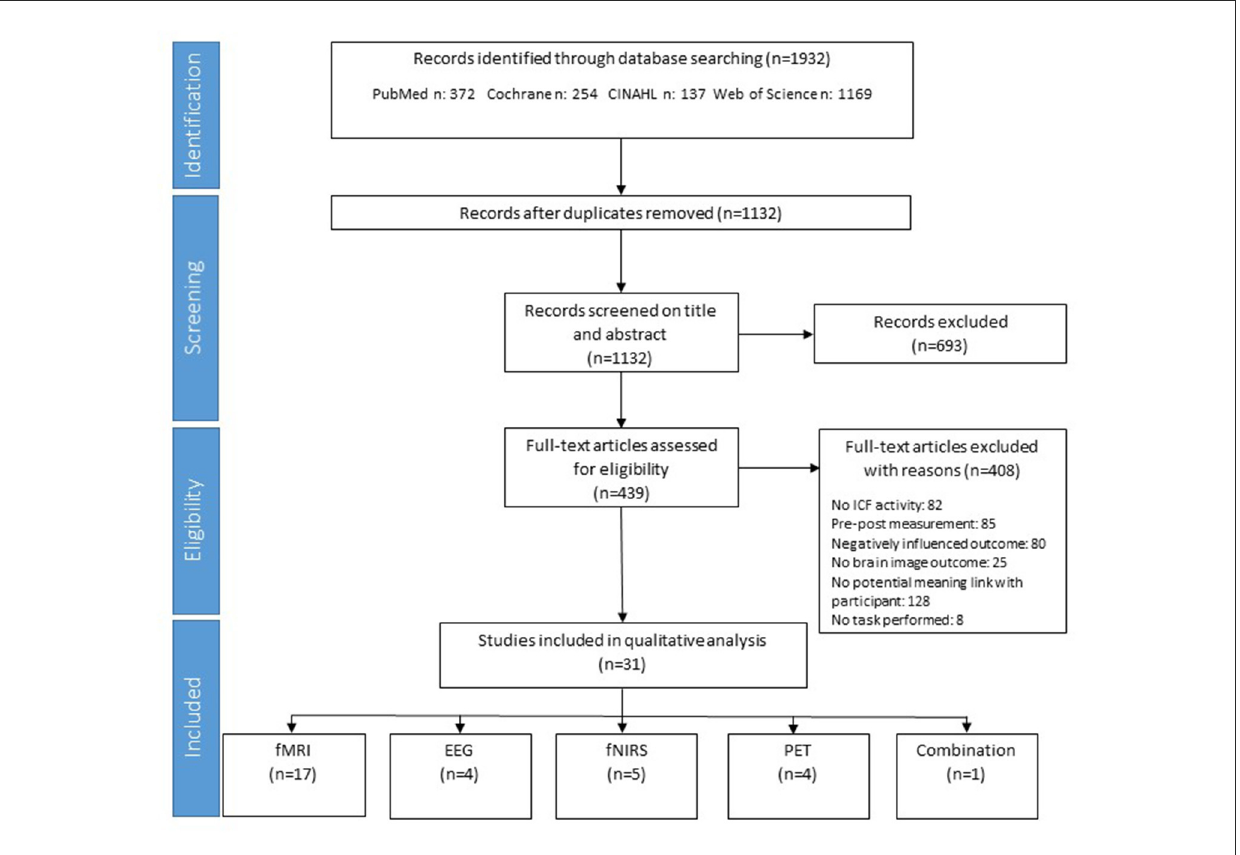
FIGURE1 Prisma flowchart of the